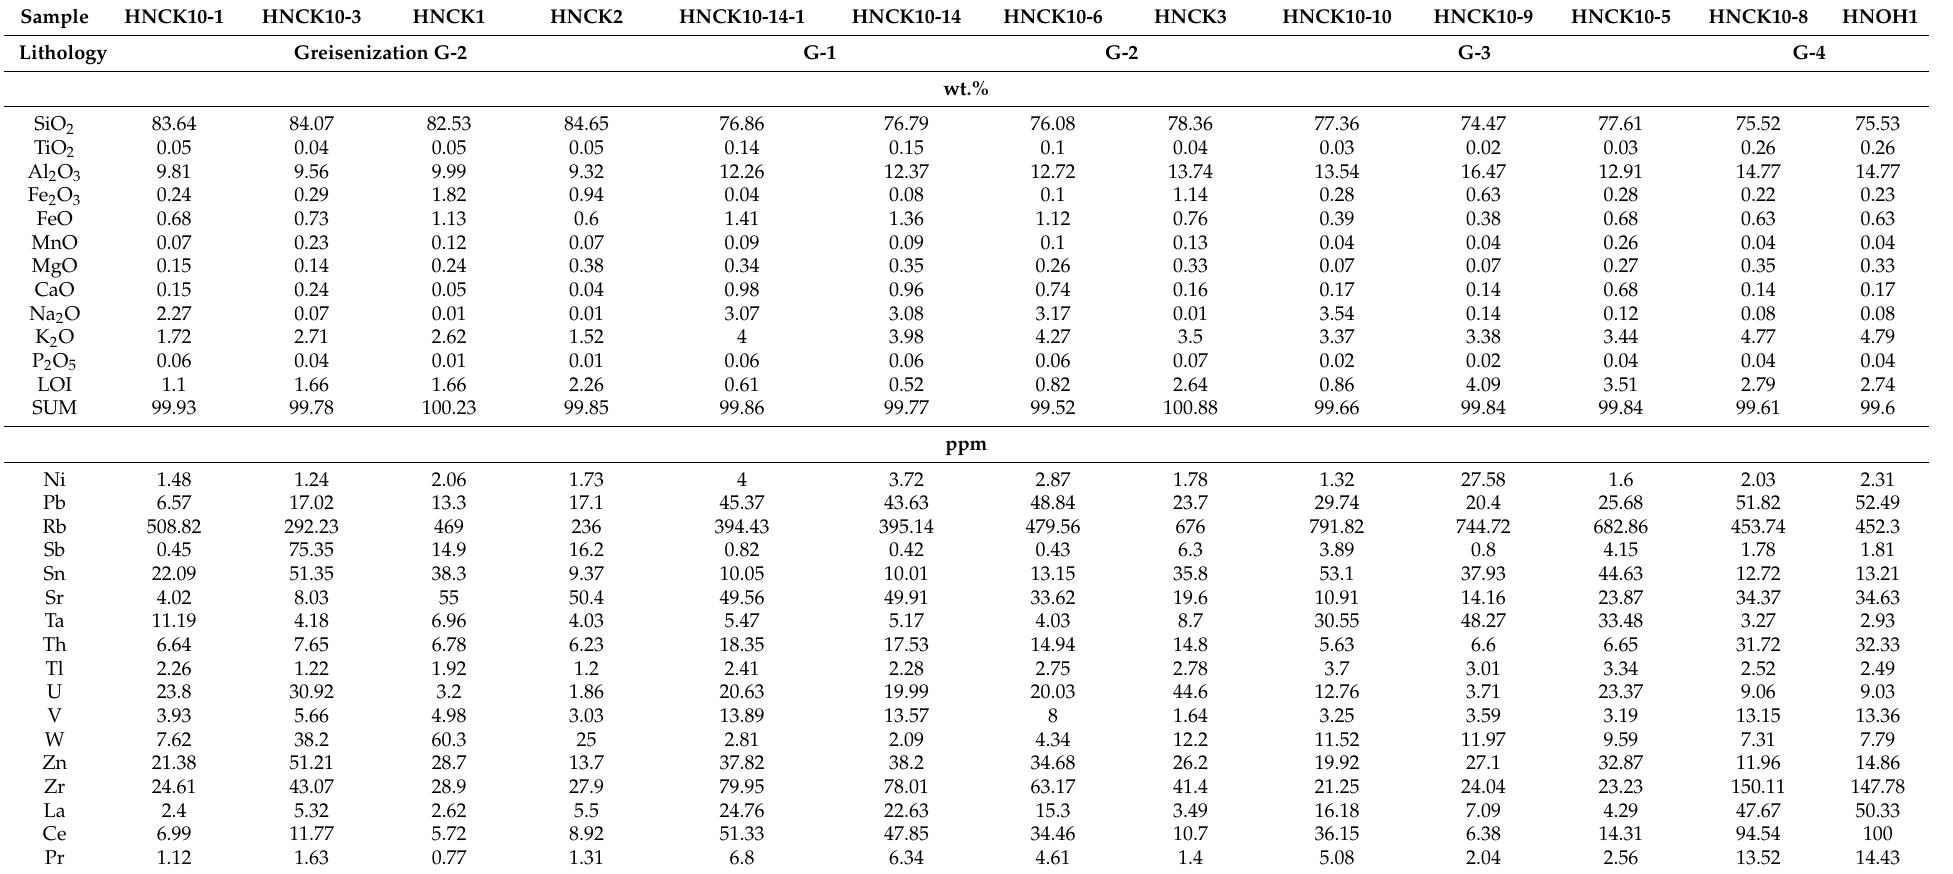
Table 3. The geochemical analysis results of samples of granitoids from Chuankou ore